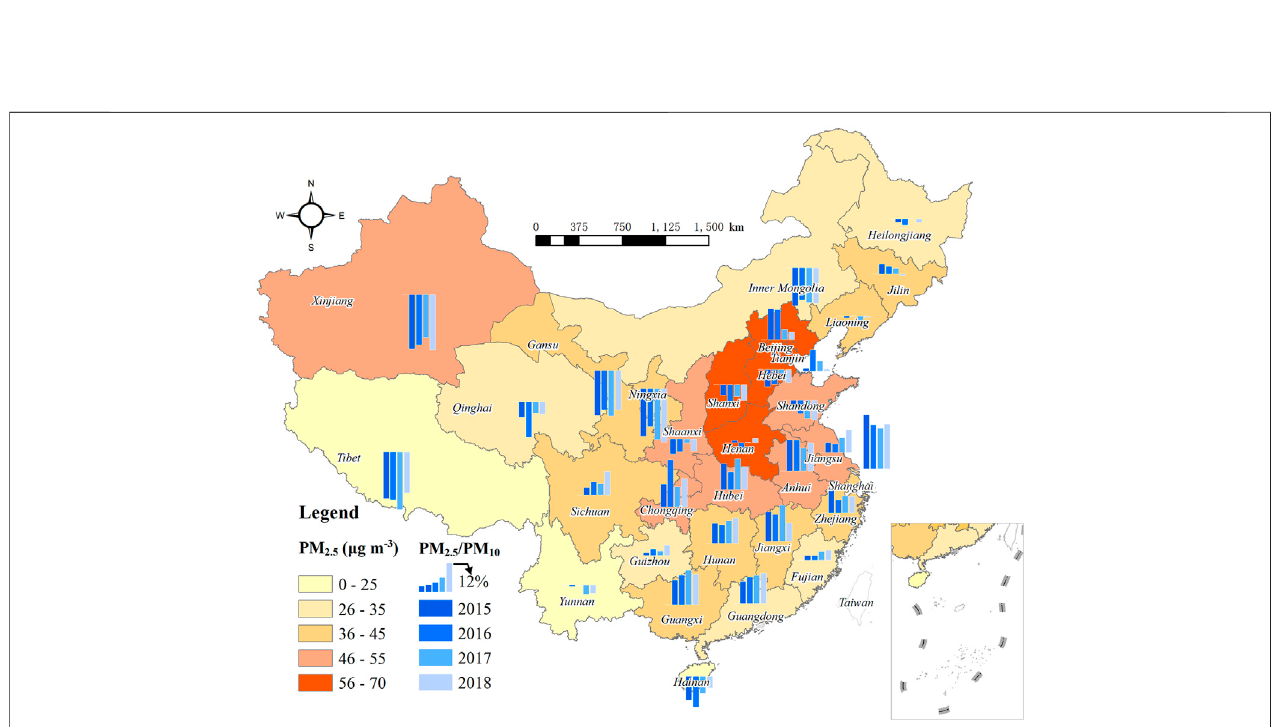
FIGURE6| ThespatialdistributionofPM 2.5 /PM 10 ratiosin31provincesalongwiththeannualaverageofPM 2.5 concentrationineachprovincefrom2015to2018.